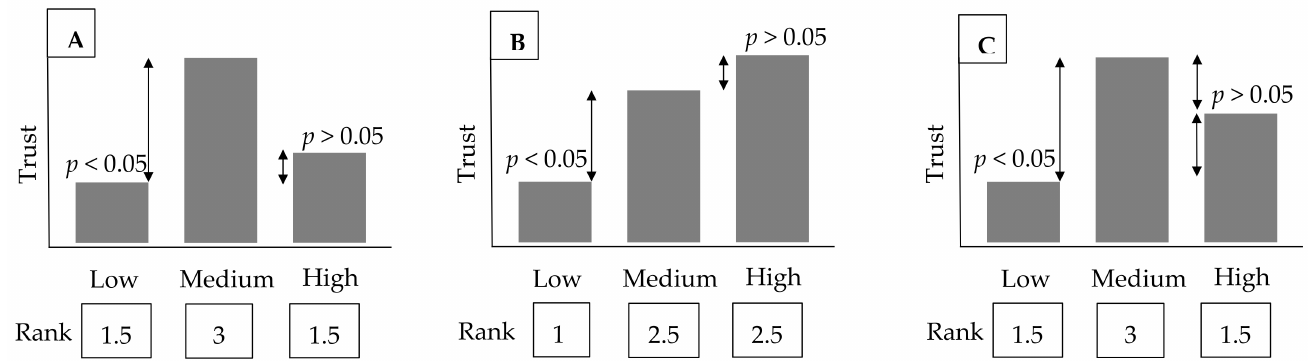
Figure 2. A methodology used to rank raw data. In the ( A ) example, the low transparency (rank: 1) is matched with trust (rank: 1.5), medium transparency (rank: 2) is matched with trust (rank: 3) and lastly, the high transparency (rank: 3) is matched with trust (rank: 1.5). As there is no significant difference in trust at low and high transparency, and trust is significantly higher at medium than at other levels, the tied-rank (1.5) is assigned to trust at low and high transparency. Other two examples ( B,C ) are explained